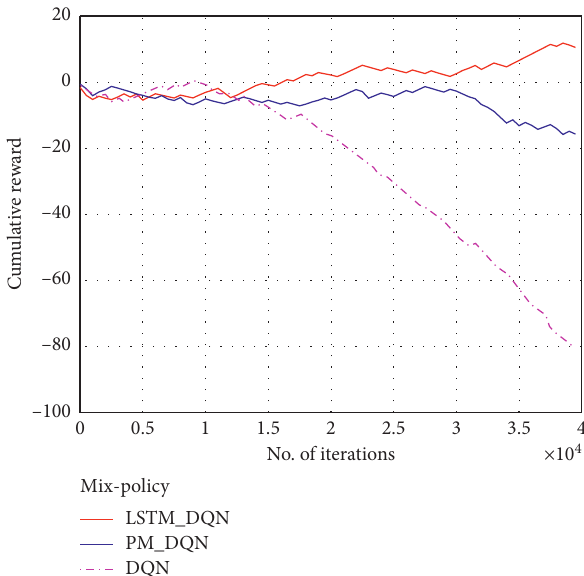
Figure 8: Relationship between the number of iterations and reward function (mix-policy).